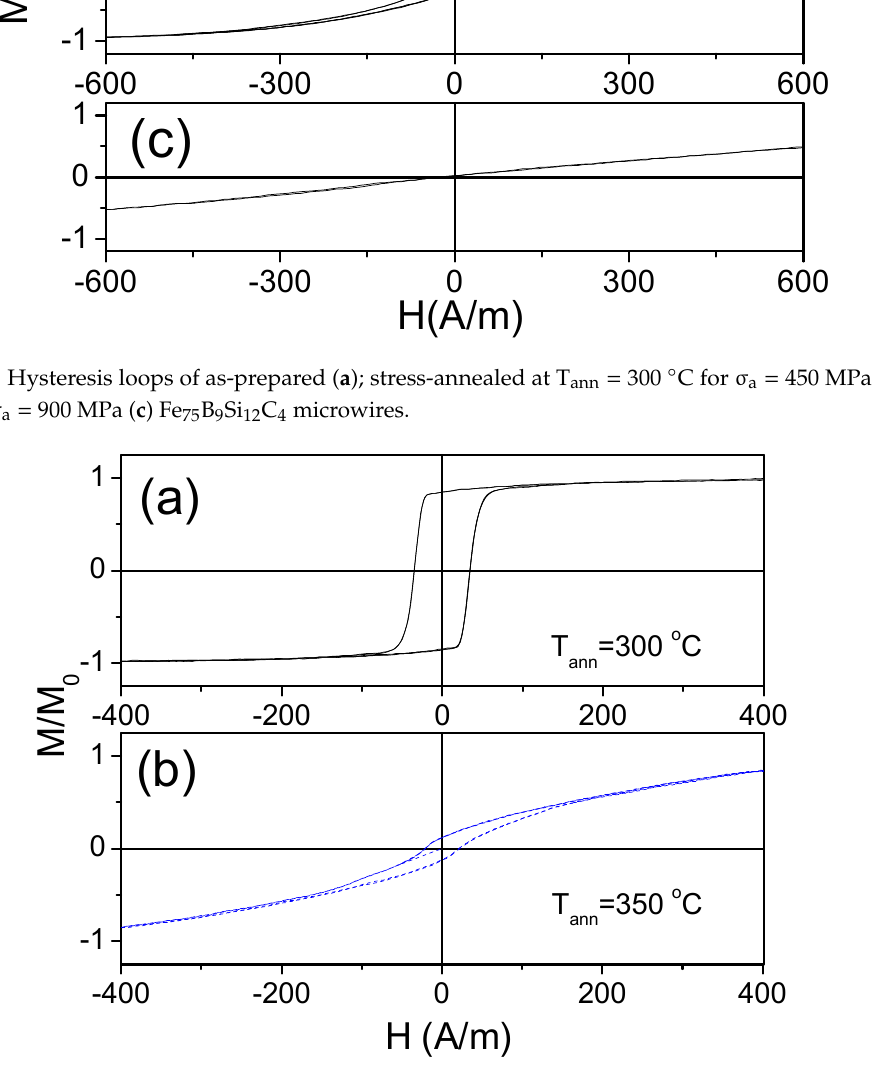
Figure 3. Hysteresis loops of stress-annealed at T ann = 300 °C ( a ) and T ann = 350 °C for σ a = 190 MPa ( b ) Fe 75 B 9 Si 12 C 4 microwires.